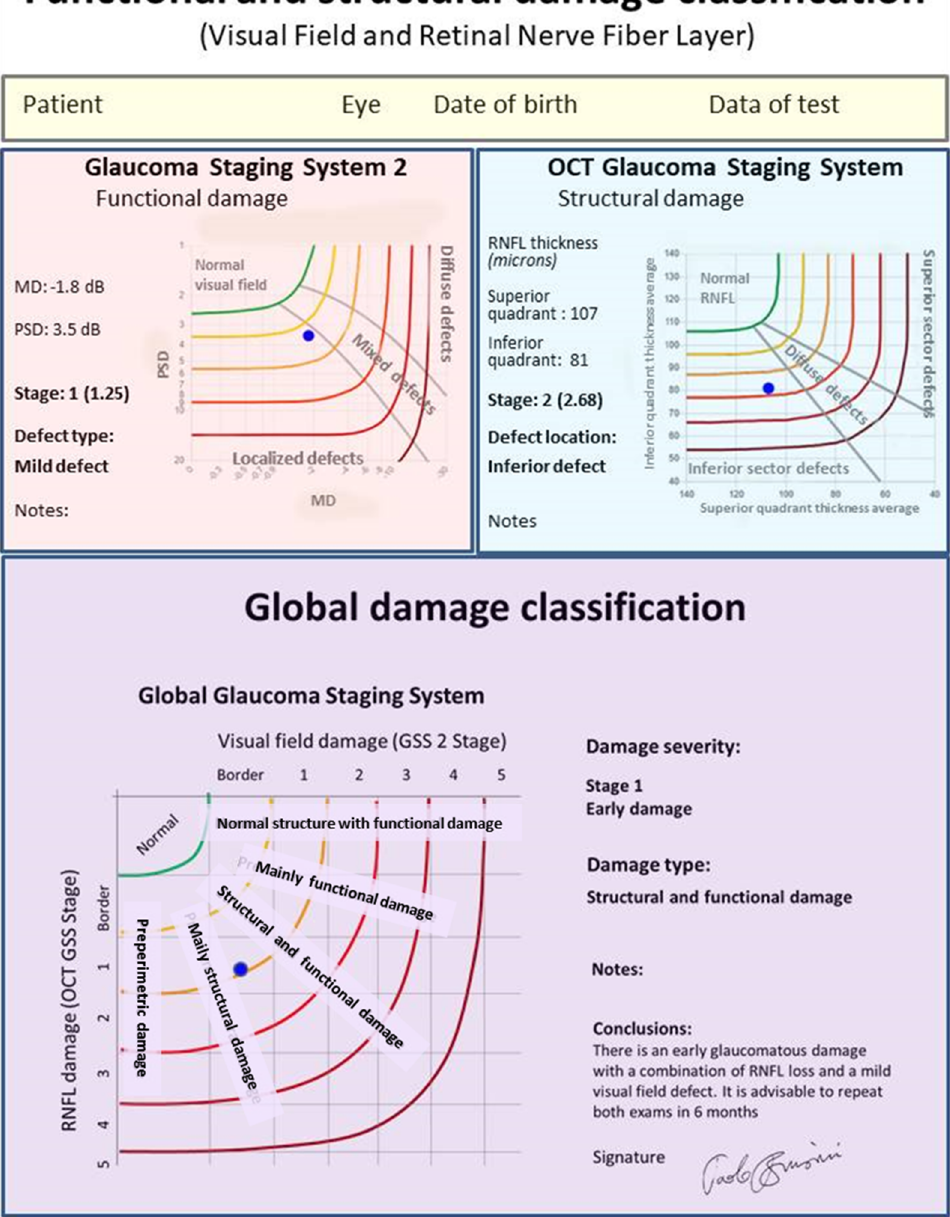
Figure 2. Printout obtained with the Glaucoma Staging System software. At the top of the page the results from both the GSS 2 and OCT GSS are displayed. At the bottom is the new GGSS display. MD: mean deviation; PSD: pattern standard deviation